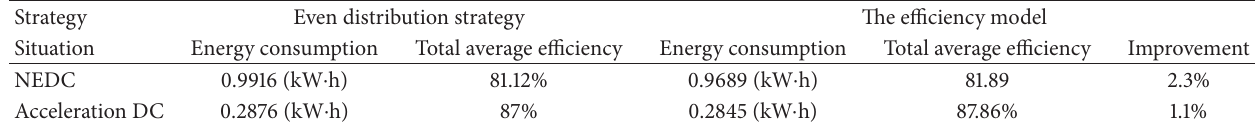
Table 3: Energy consumption result.